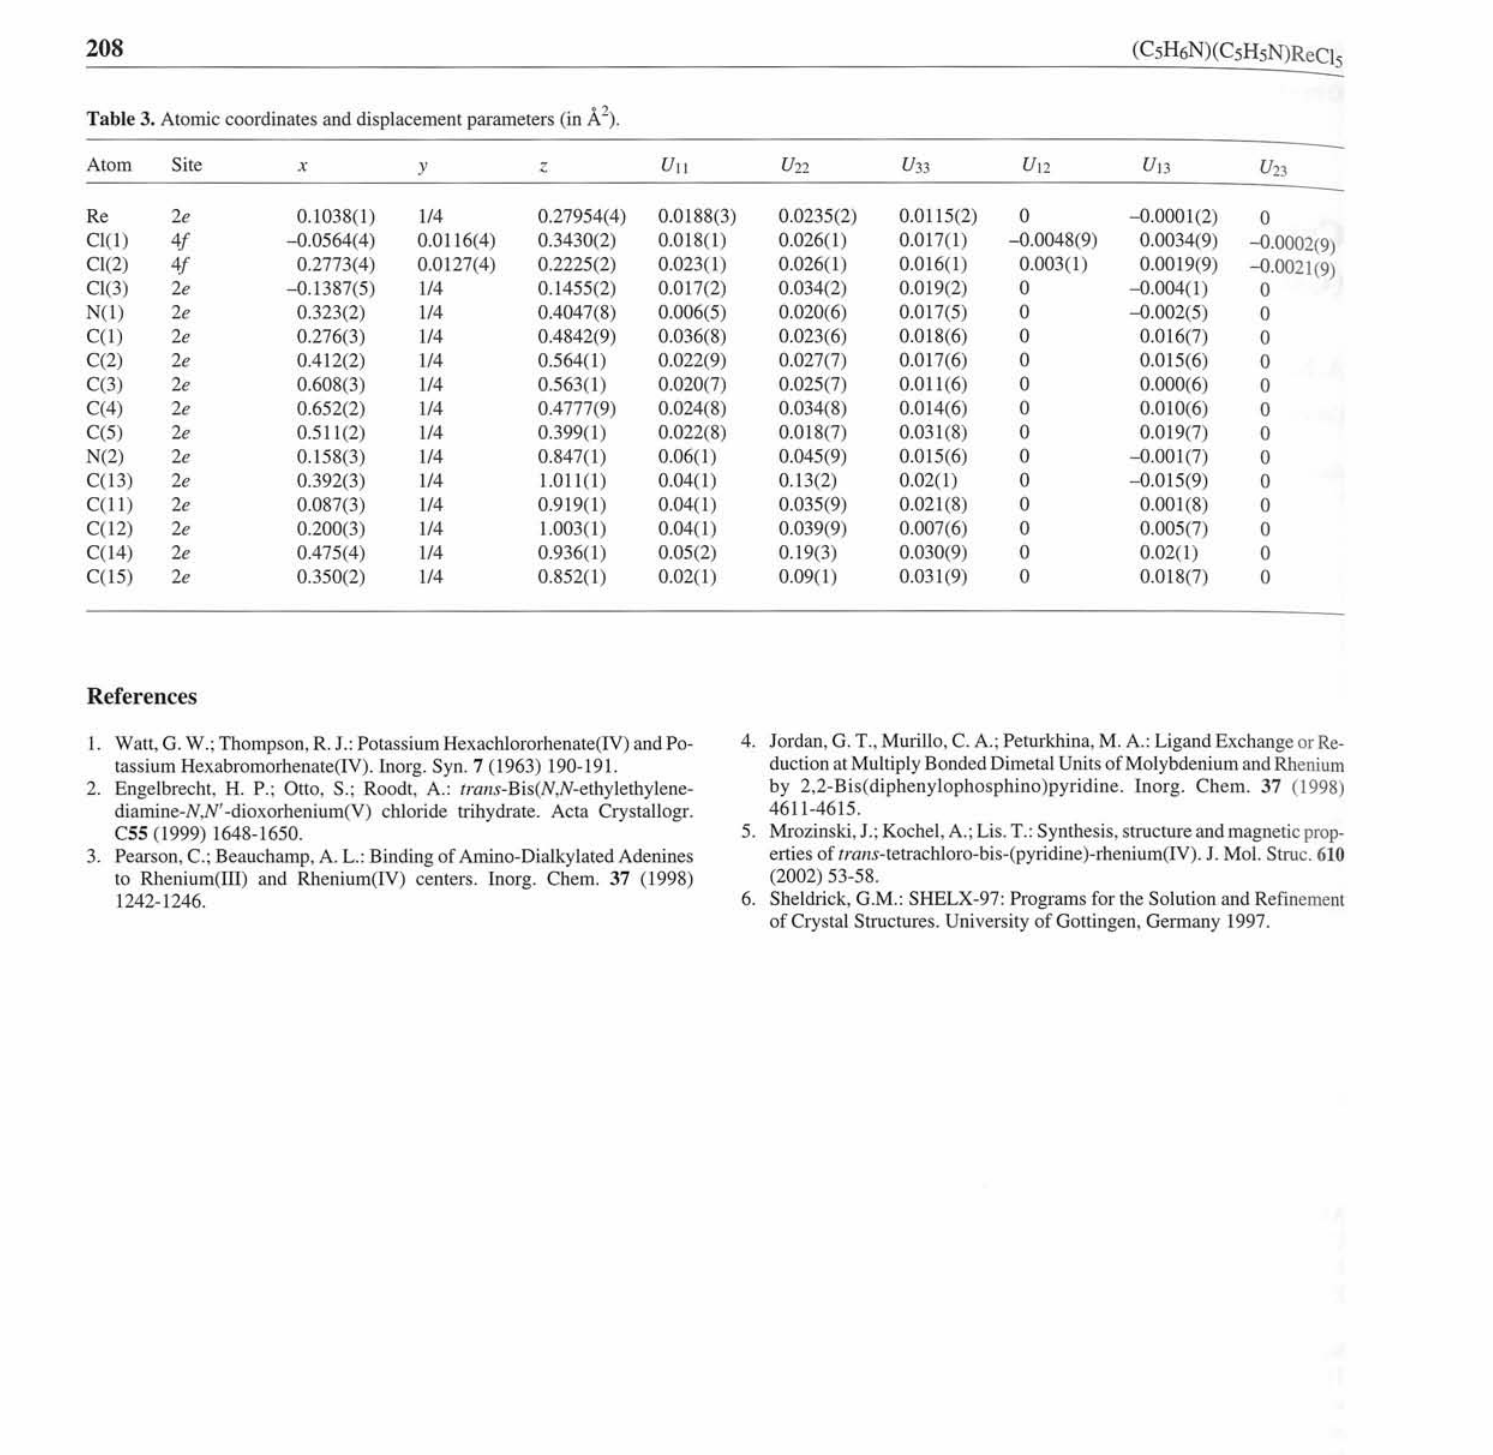
Table 3. Atomic coordinates and displacement parameters (in À 2